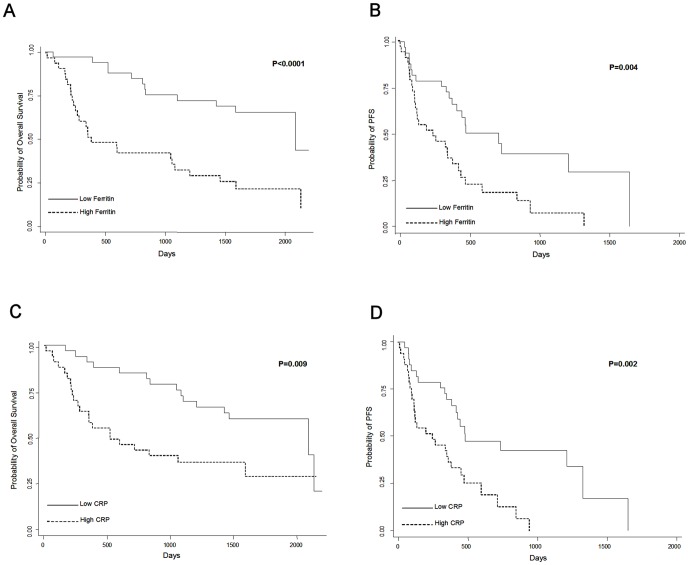
Serum ferritin and CRP predict response to trastuzumab-containing therapy.Pre-treatment serum ferritin and CRP predict overall survival (A&C respectively) and progression-free survival (PFS; B&D respectively) in patients receiving trastuzumab-containing therapy. Low serum ferritin or CRP (<250 ng/ml and <7.25 mg/l respectively) had an overall better clinical outcome than high ferritin or CRP. Difference in OS and PFS were analyzed by Kaplan-Meier survival model with the median serum ferritin or CRP value as a cutoff point.